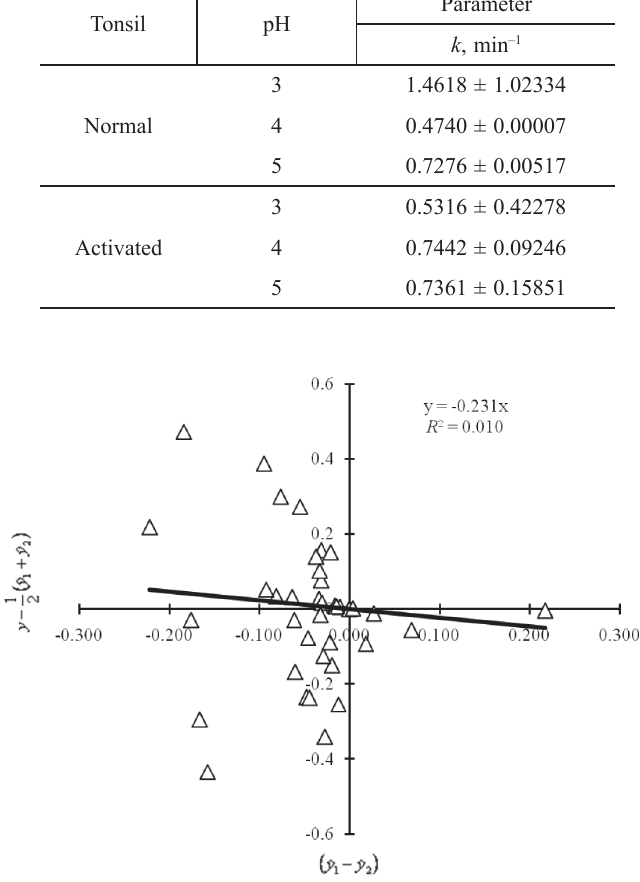
Fig. 6 – Application of the nonintrinsic parameter method for comparing the pseudo second order (1) and Lagergren model (2) for Zn sorption on Tonsil materials